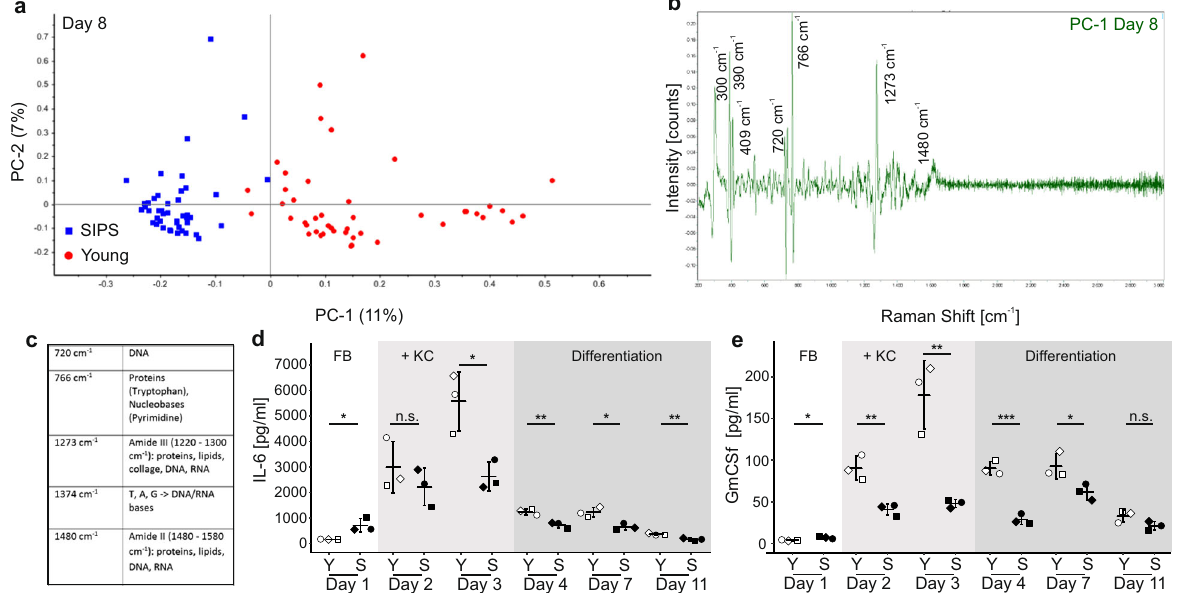
Fig. 3 Distinct changes in the chemical composition of senoskin supernatants. a – c Raman microspectroscopy discriminates between supernatants from young and senoskin models. Raman spectra were enhanced using gold nanoparticles, which were dried overnight on a glass slide, before supernatants from young or senoskin equivalents (from day 8, differentiation phase) were added. Spectra were acquired with a 785-nm laser over a range of 400 – 3000 cm − 1 . A total of 15 spectra per sample were collected; three biological samples were measured per condition. The fi rst derivative was calculated, and after unit vector normalization, spectra were subjected to principal component analysis (PCA, a ). In b , the main differences in Raman spectra of supernatants from senoskins and young skin equivalents are visualized as peaks. Panel c gives an overview of the most prominent bands and their corresponding major components. d , e Cytokine pattern in supernatants of sensoskin equivalents. IL-6 ( d ) and GmCSF ( e ) levels were analyzed in supernatants from young and senoskin equivalents via ELISA. Samples were taken on days 1, 2, 3, 4, 7, and 11, whereas the fi rst three time points re fl ect the growing phase of the experiment. Keratinocytes are added on day 2. On day 4, differentiation of KCs is induced via generation of an air – liquid interface. Per condition, three independent replicates from one donor are shown. Statistical analysis was performed using unpaired t test (Bonferroni corrected); error bars indicate SD. n.s ≥ 0.05; * p < 0.05; ** p <